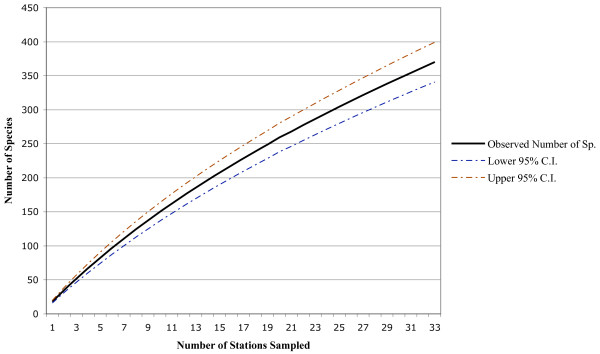
Species accumulation curve based on sampling effort outlined in Table1.